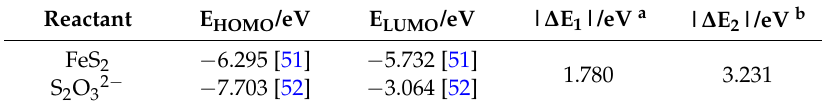
Table 1. The absolute values of difference between the frontier orbital energy of pyrite and thiosulfate anion. Reactant E HOMO /eV E LUMO /eV | ∆ E 1 |/eV a | ∆ E 2 |/eV b FeS 2 − 6.295 [51] − 5.732 [51] 1.780 3.231 S 2 O 32 − − 7.703 [52] − 3.064 [52]